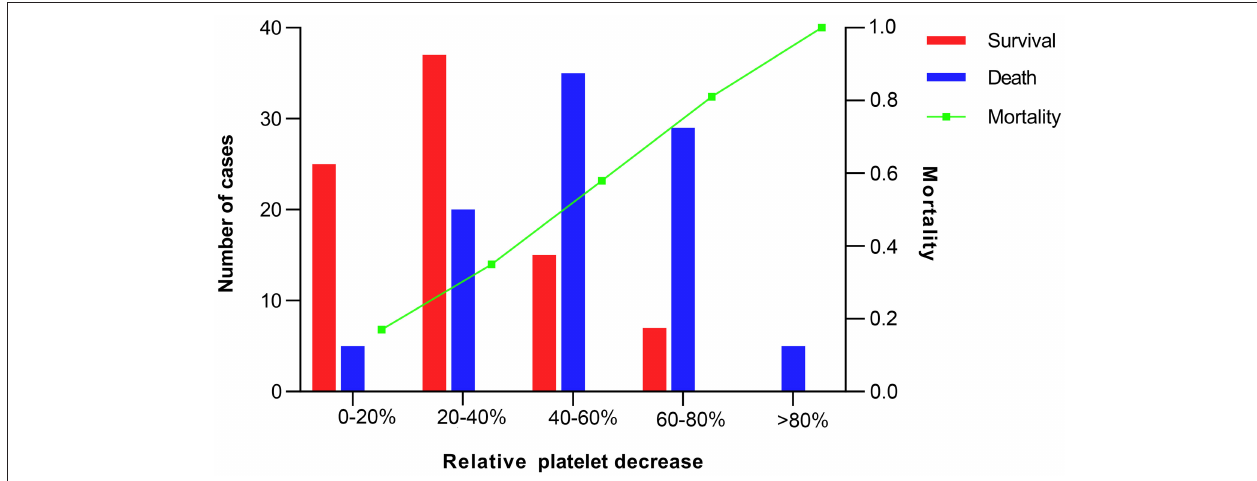
FIGURE 2 | Number of cases and mortality according to intervals of relative decrease in platelet count.